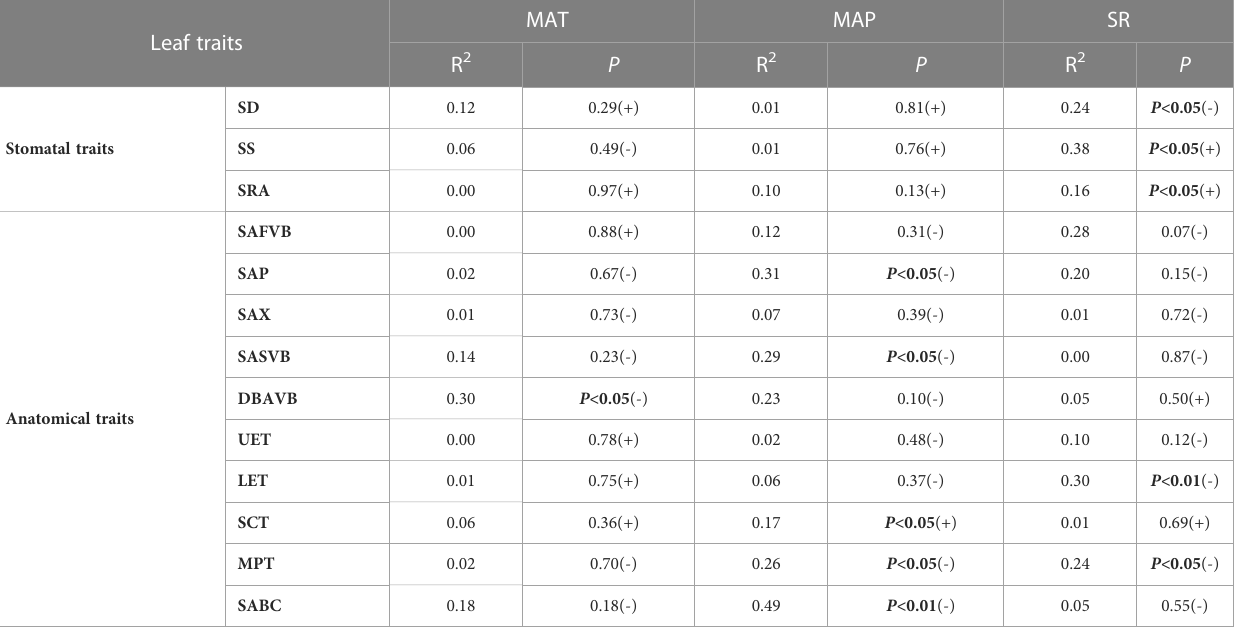
TABLE 2 Relationship between climate and leaf traits (stomatal and anatomical traits) of moso bamboo analyzed using linear mixed-effects models.